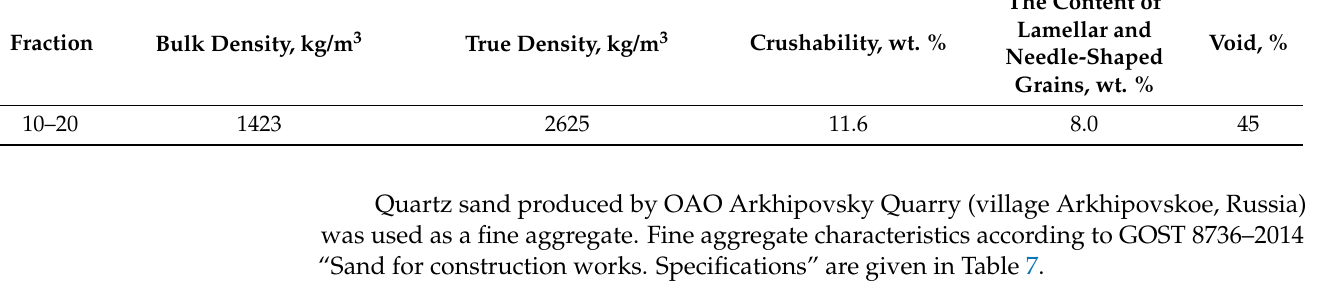
Table 7. Characteristics of quartz